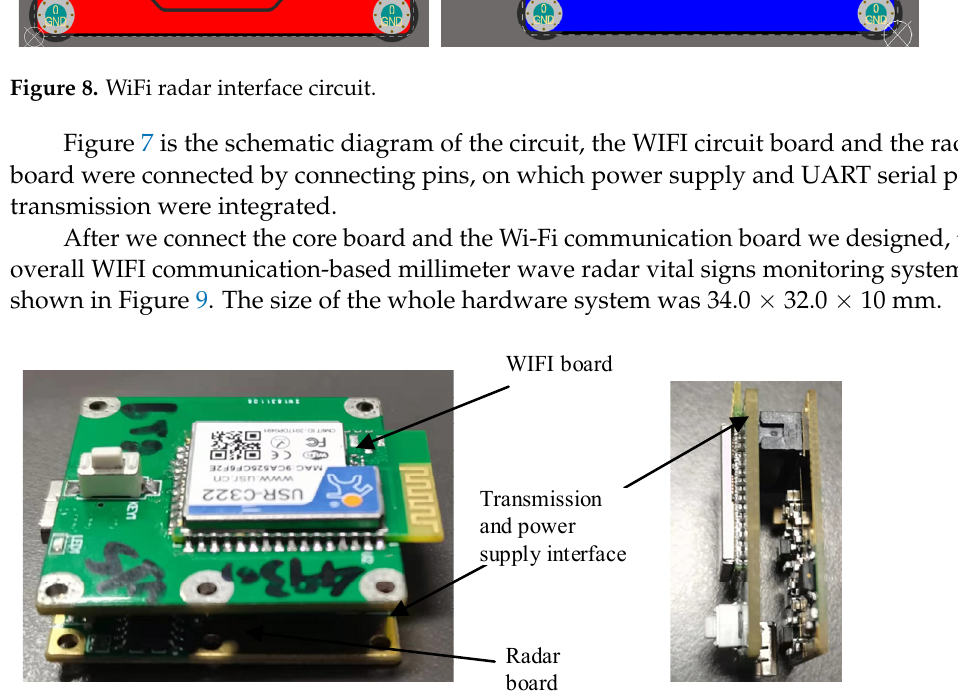
Figure 9. The Overall physical diagram of the hardware.